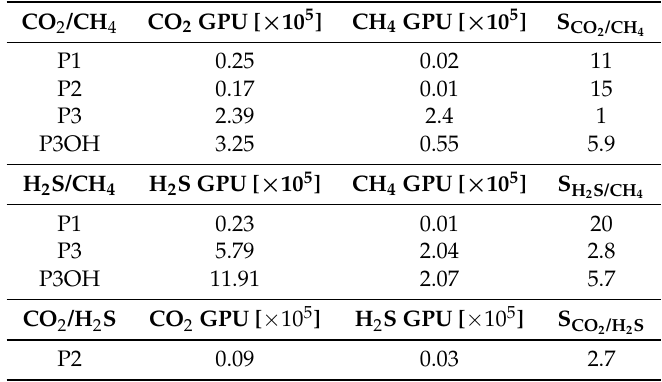
Table 1. Permeability and selectivity calculated for different gas mixtures and pore